Question: What caption would you write for this figure?
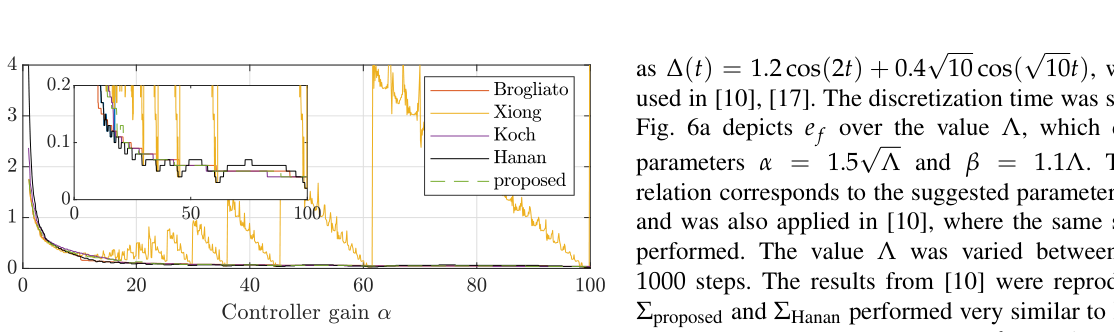
Answer: Convergence time tC over varying parameter α.